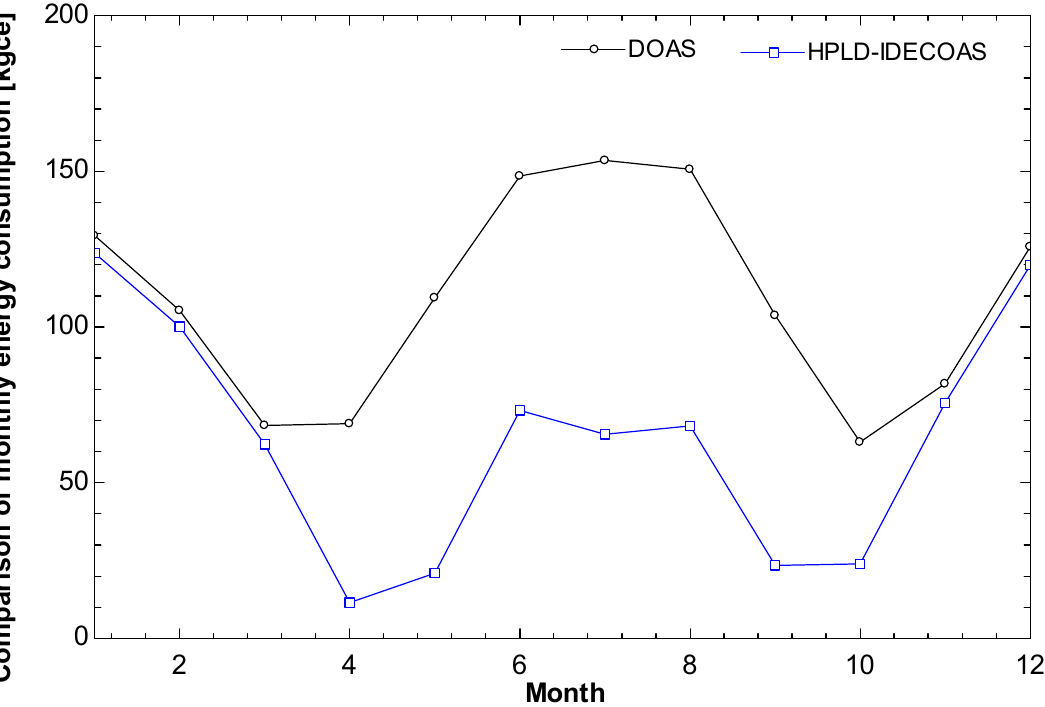
Energies 2019 , 12 , x FOR PEER REVIEW Figure 16. Comparison of monthly energy consumption in Beijing. Figure 16. Comparison of monthly energy consumption in Beijing.